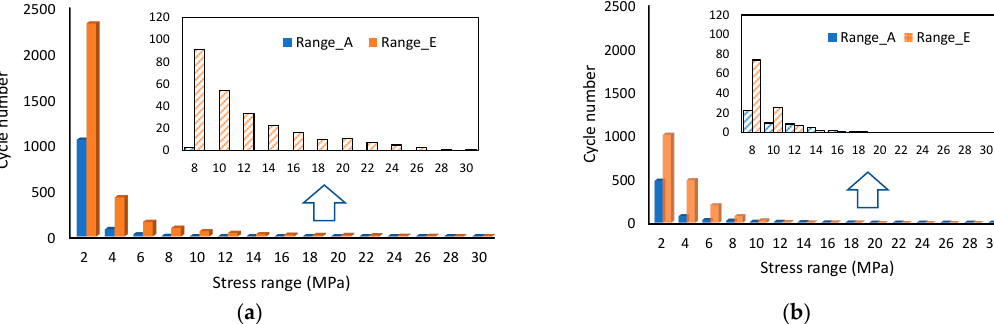
Figure 17. Time-dependent laws of suspender stress under defined fatigue load spectrum. ( a ) Range_A, ( b ) Range_E.